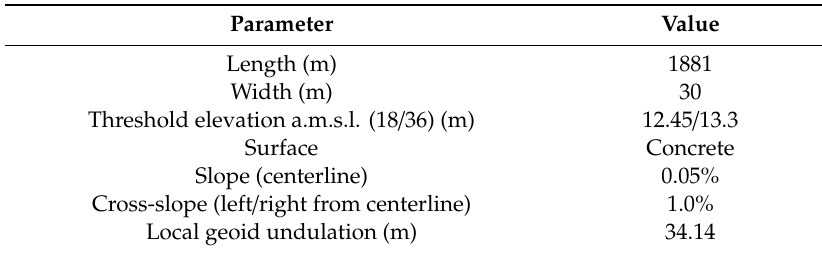
Table 1 . Selected physical characteristics of the runway used as a testbed in this study. Source: Aeronautical Information Publication (AIP) Turkey.